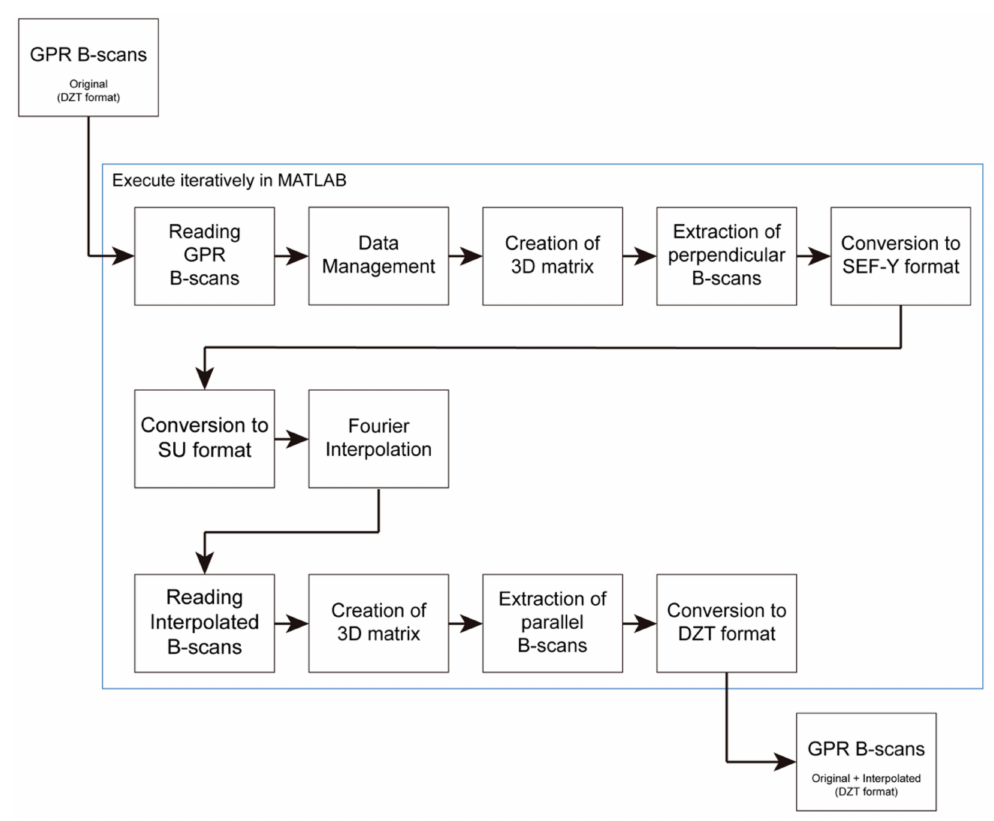
Figure 6. Schematics of the numerical implementation of the INT-FFT